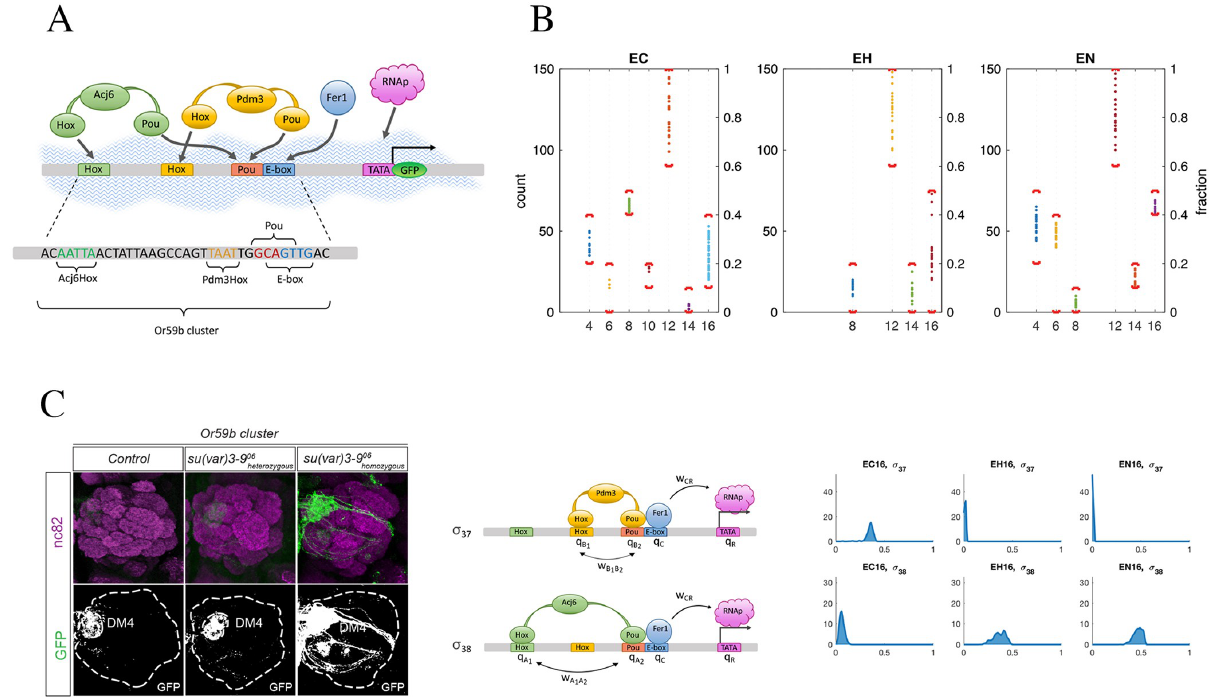
Fig 1. (A): Sketch of the Or59b cluster and TFs involved in the regulation. (B): Experimental countings of the number of GFP-expressing OSNs in the DM4 glomerulus, see Table A of S1 Text for more details. The left axis gives the absolute count, the right axis the normalized value. In the horizontal axis, the experiments are listed as reported in Table 1. For each experiment, the red brackets denote the intervals [lower bound, upper bound], reported also in Table 1. (C): Left panel: whole-mount brain staining showing the expression of GFP driven by the intact Or59b cluster (row E16 in Table 1). The upper row shows synaptic neuropil regions labeled with the presynaptic marker nc82 (magenta). GFP is shown in the lower row. In this paper, only the DM4 glomerulus is of relevance for Or59b expression. The leftmost staining corresponds to normal chromatin (case EC16 of Table 1), the middle one to heterozygous su(var)3-9 mutant (case EH16 of Table 1) and the right one to homozygous su(var)3-9 mutant (case EN16 of Table 1). Middle panel: the two configuration states contributing the most to expression, as suggested by our model: σ 37 and σ 38 . See Figs. A-B of S1 Text for a list of all configurations. Right panel: the distributions of the probabilities P ( σ 37 ) and P ( σ 38 ). When passing from normal chromatin to su(var)3-9 mutants, the first decreases and the second increases.